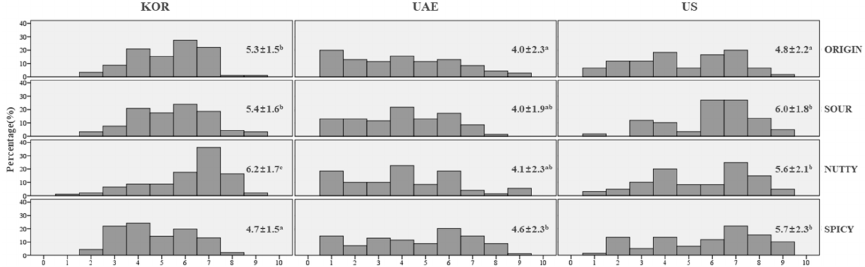
Figure 1. Histogram of overall liking ratings (mean ± SD) of salad dressing samples evaluated by KOR, UAE, and US consumers. KOR, UAE, US denote South Korean, United Arab Emirates, and Americans, respectively. ‡ Samples sharing the same superscript letters within the same country do not differ significantly among the products ( α = 0.05).